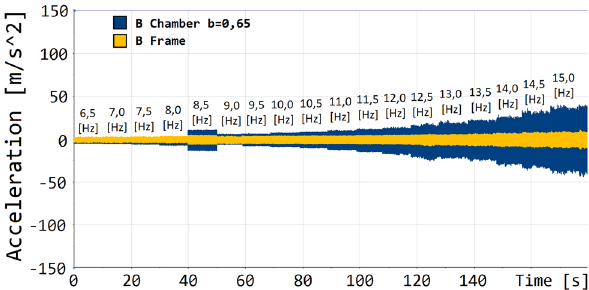
Figure 4: Quasi steady start up. Accelerations of the chamber and drive frame for the chamber fi lling degree equal to 0.65.